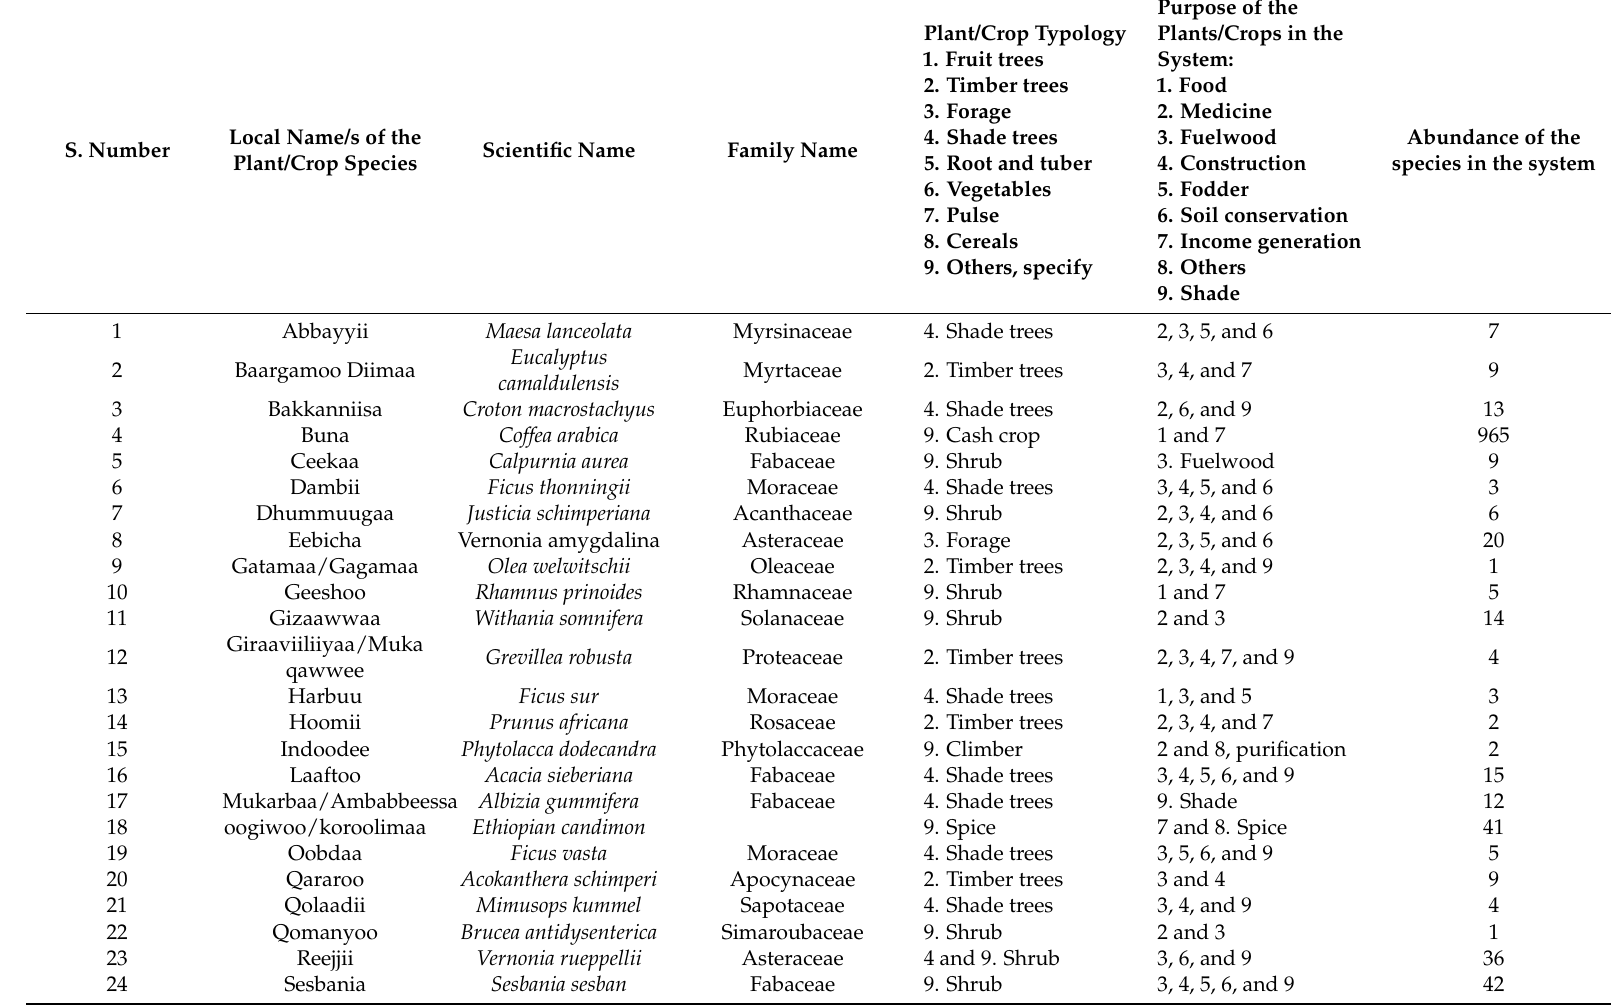
Table A3. Species Compositions of Plantation Coffee